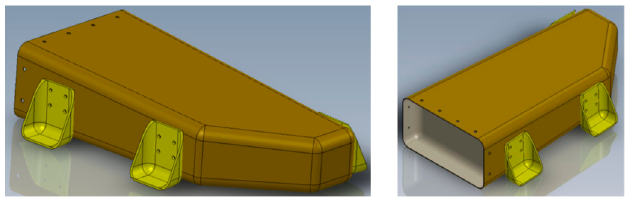
Figure 3. Electronic box design.